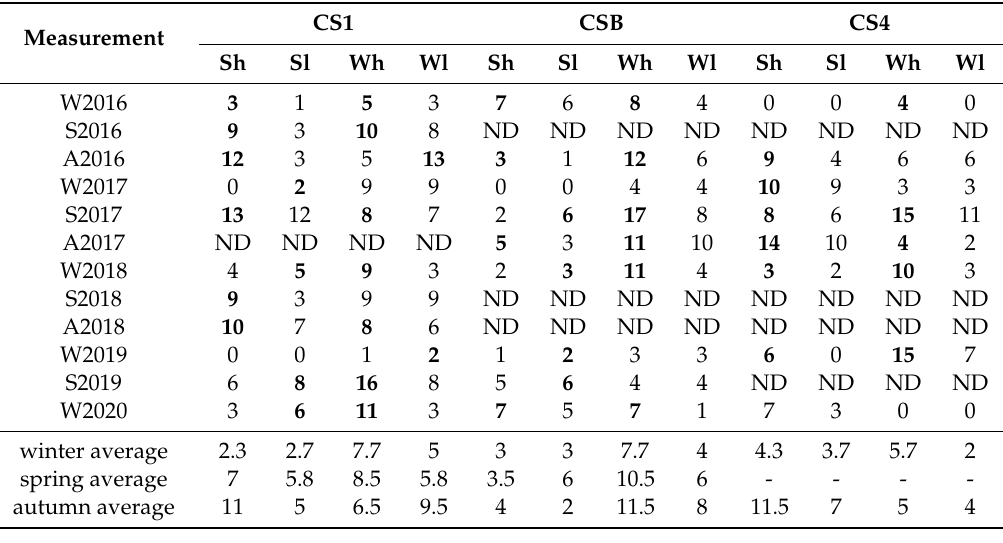
Table 6. The occurrence numbers and the type of the macro-turbulent wedges observed based on the LISA (Local Indicators of Spatial Association) analyses from all measured time steps at CS1, CSB, and CS4 measurement locations. See the marked dots of statistically significant flow wedges from Figures 3–8. Sh = strong high flow wedges, Sl = strong low flow wedges, Wh = weak high flow wedges, Wl = weak low flow wedge. Bolded values show whether the high or low flow clusters are more than the other. If high and low flow wedges have the same amount, no values are bolded. ND = no data analyzed. Note that other time steps had approximately 600 s (i.e., 10 min) long measurements, except on S2018, W2019, and W2020 the measurements were shorter (see Tables 2 and 3). Note that the average values are calculated based on the measurement times of around equal length (i.e., others except S2018, W2019, and W2020). At CS4, there was spring measurement only from S2017, thus the average value was not